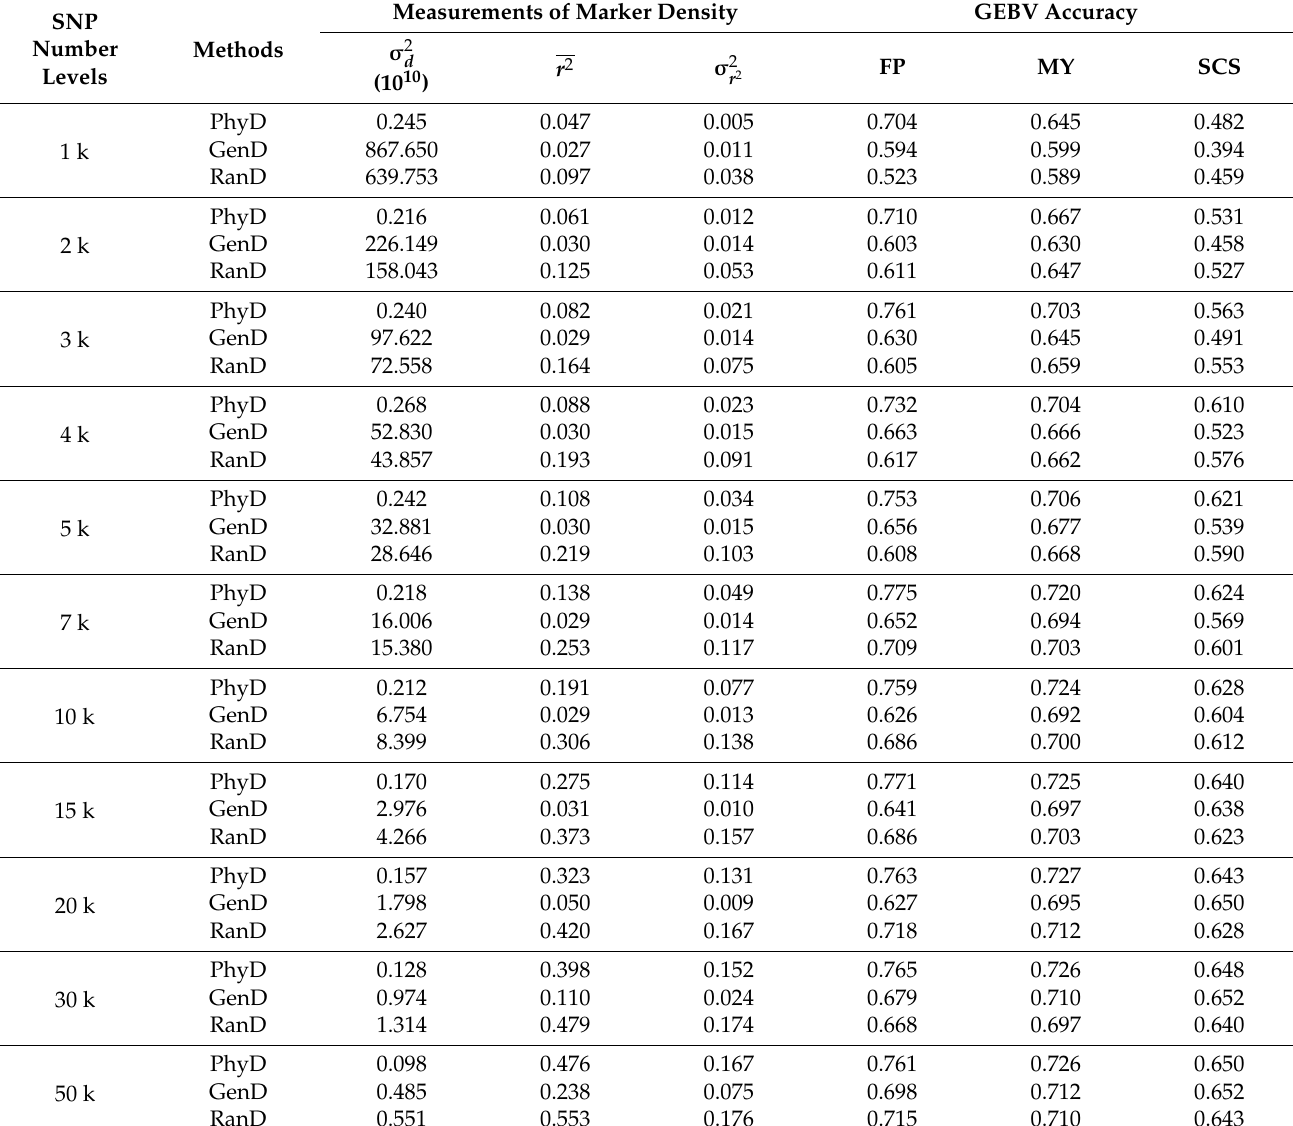
number level contribute equally to the results of the correlation analysis. Table 1. The measurements of marker density and GEBV accuracy for low and moderate-density panels constructed by PhyD, GenD or RanD. Each GEBV accuracy in the table was calculated by a 10 × 10